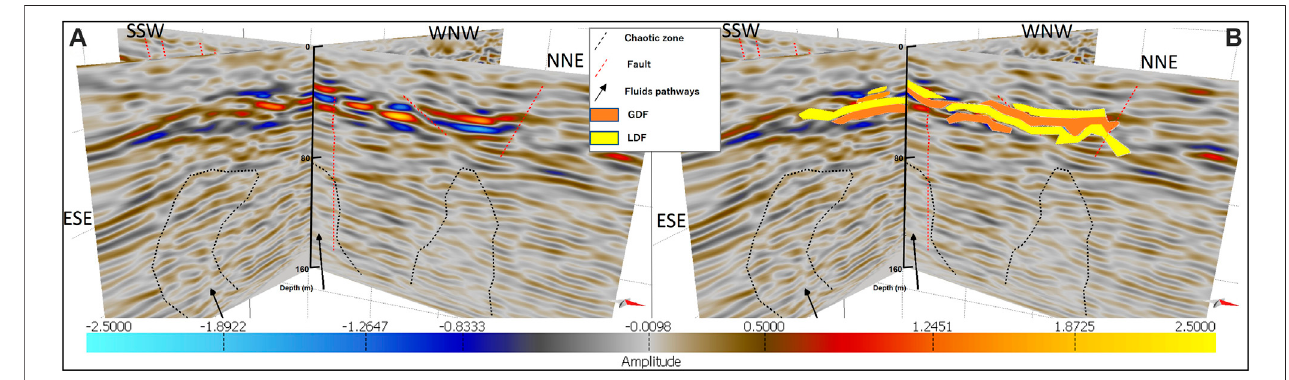
FIGURE 9 | Seismic multi-2D interpretation in the depth domain for both pro fi les A and B shows the uprising fl uid pathways (black arrows) and chaotic zones (dashed curves). (B) After adding both GDF and LDF zones to (A) , view from the north-west sector.